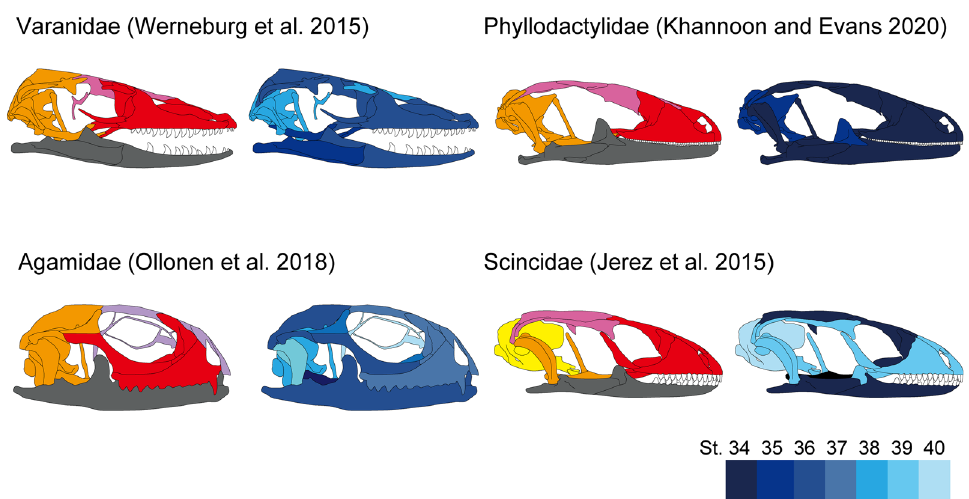
Figure 5. Comparison of ossification sequence and modularity of lizard skulls. These figures are based on comparing the ossification sequence by Khannoon & Evans 26 in the developmental stages (blue values) according to Dufaure and Hubert 51 . The ossification sequence patterns with the modules of the same family are compared, respectively 26,52–54